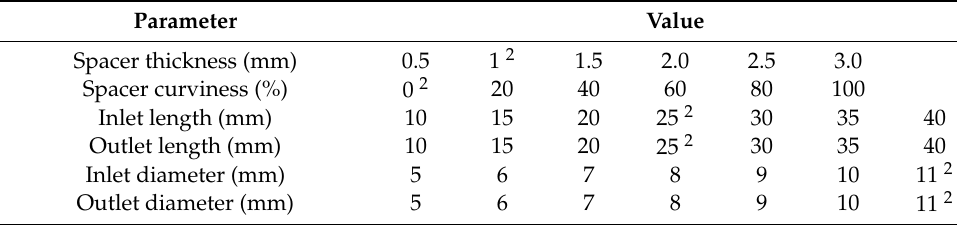
2 Values for the reference